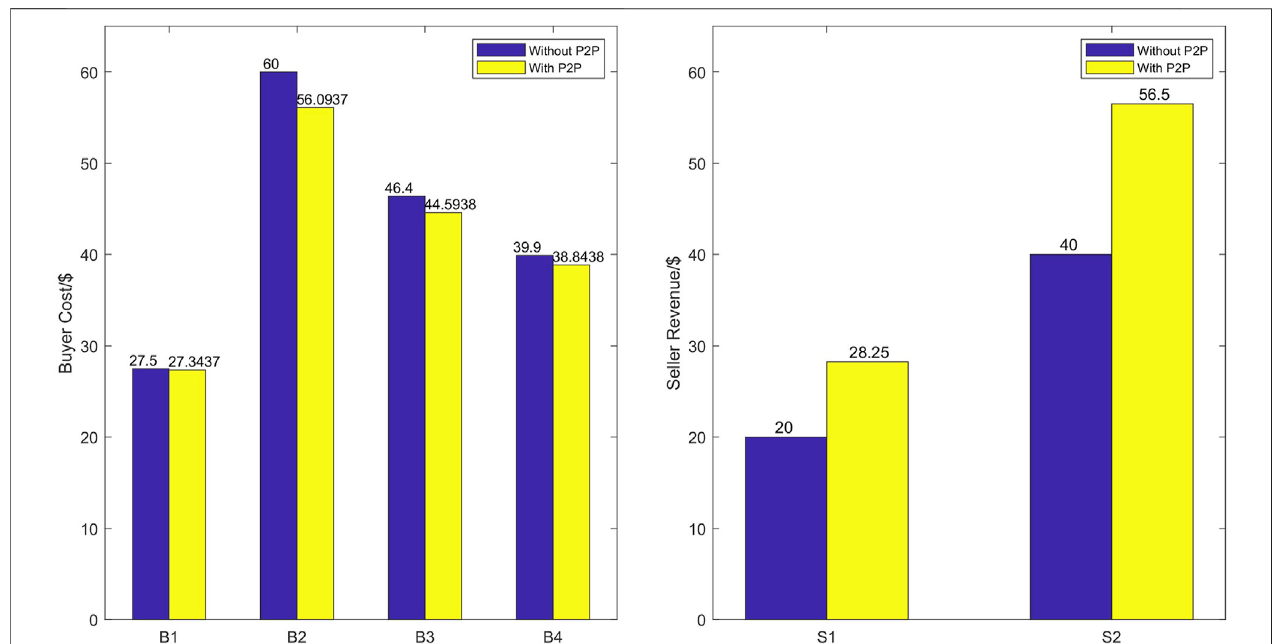
FIGURE 7 | Costs and revenues comparison between two scenarios.